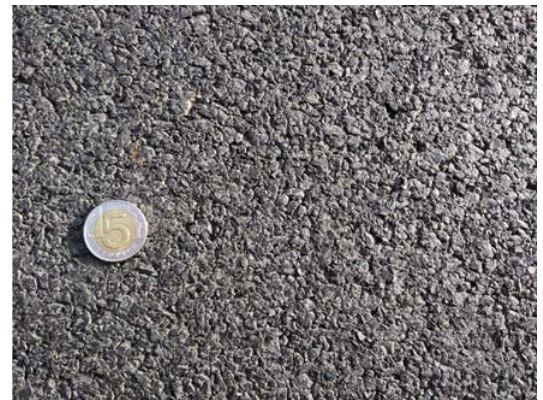
Figure 20. Close-up view of the poroelastic wearing course.